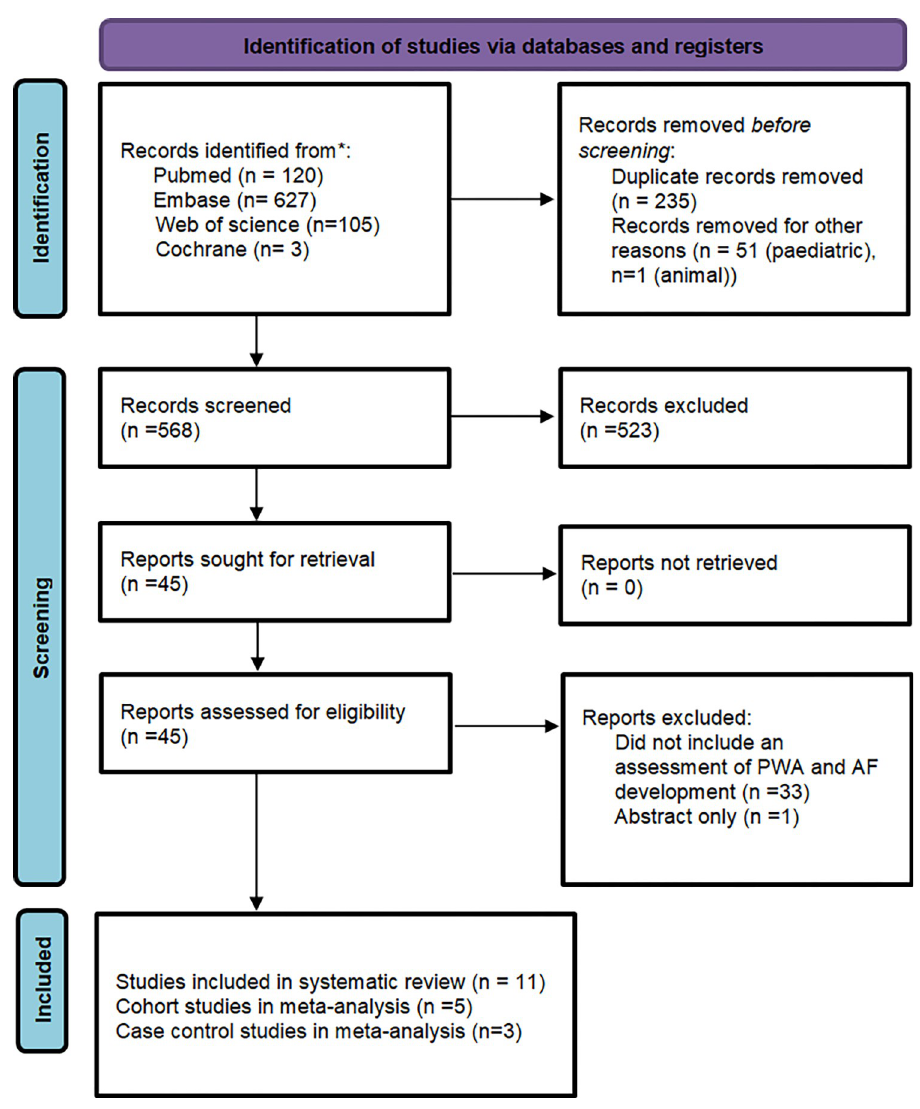
Fig 1. PRISMA diagram for systematic review and